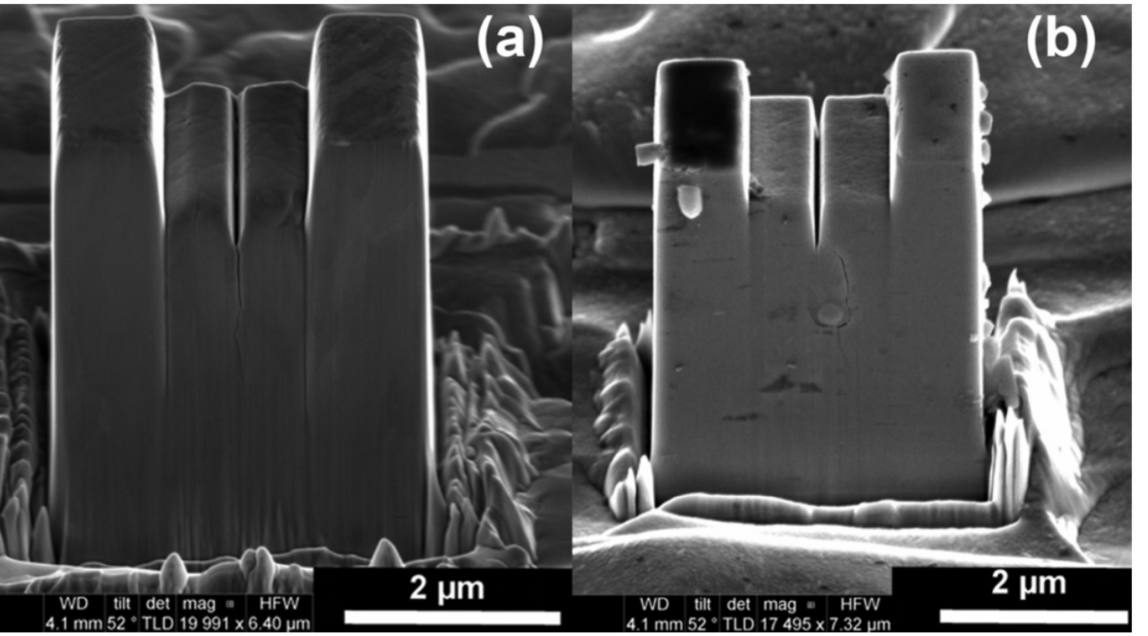
Figure 24. Cracking in micro DCBs made from ( a ) CrN coating and ( b ) CrAlN/Si 3 N 4 coating